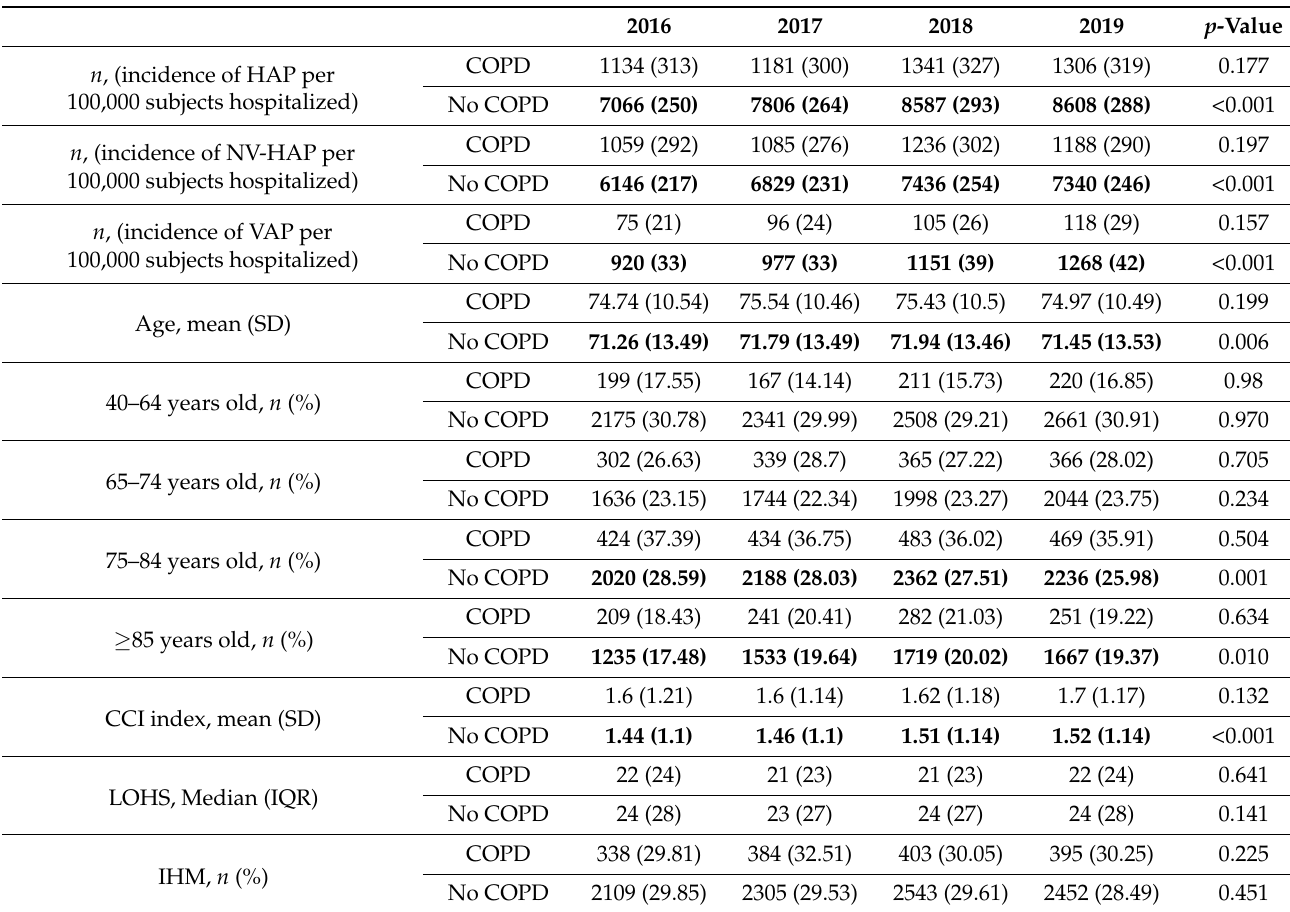
Table 1. Incidence, clinical characteristics, and in-hospital outcomes of patients hospitalized with hospital-acquired pneumonia (HAP), in Spain from 2016 to 2019 according to presence of